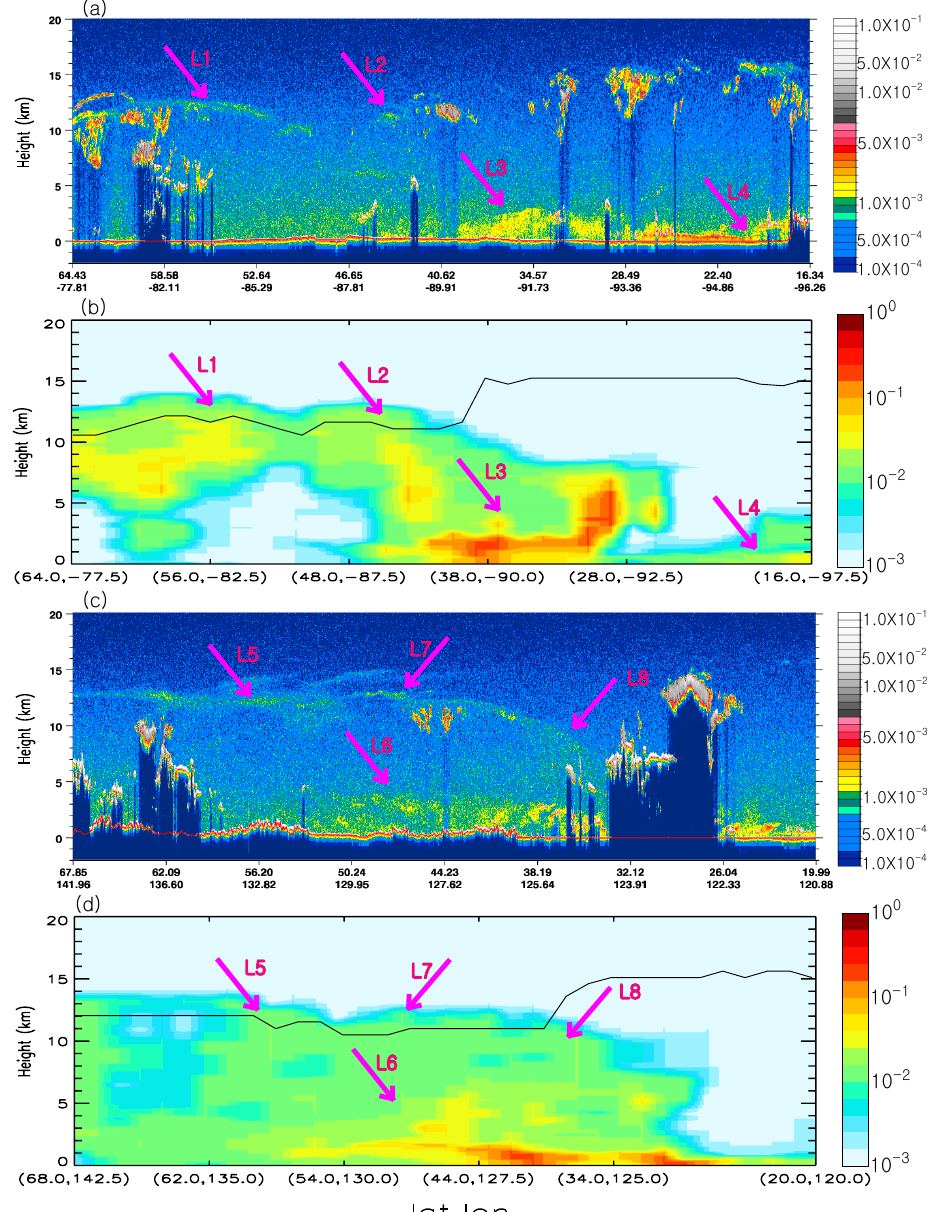
Fig. 6. (a) vertical distribution of 532nm total attenuated backscatter (km − 1 sr − 1 ) measured by the CALIOP lidar, and (b) the corresponding distribution of tropopause (black line) and the simulated sulfate aerosol extinction coefficient (km − 1 ) at 550nm for the CALIPSO ground track in Fig. 5a on 14 August 2008. (c) and (d) are respectively the same as (a) and (b) for the CALIPSO ground track solid black line in Fig. 5e. The pink arrows and letters highlight the regions of large volcanic AOD, as discussed in Sect.